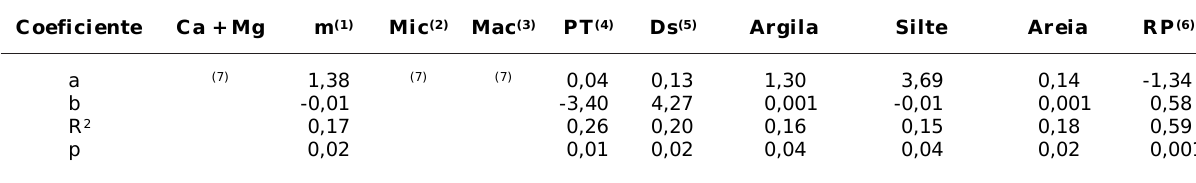
Quadro 2. Coeficiente linear (a) e angular (b) da equação da reta ajustada, coeficientes de determinação (R 2 ) e o nível de significância (p), sendo (X) as propriedades do Argissolo Vermelho distrófico arênico e (Y) a densidade radicular. Foram utilizados 28 pares de dados